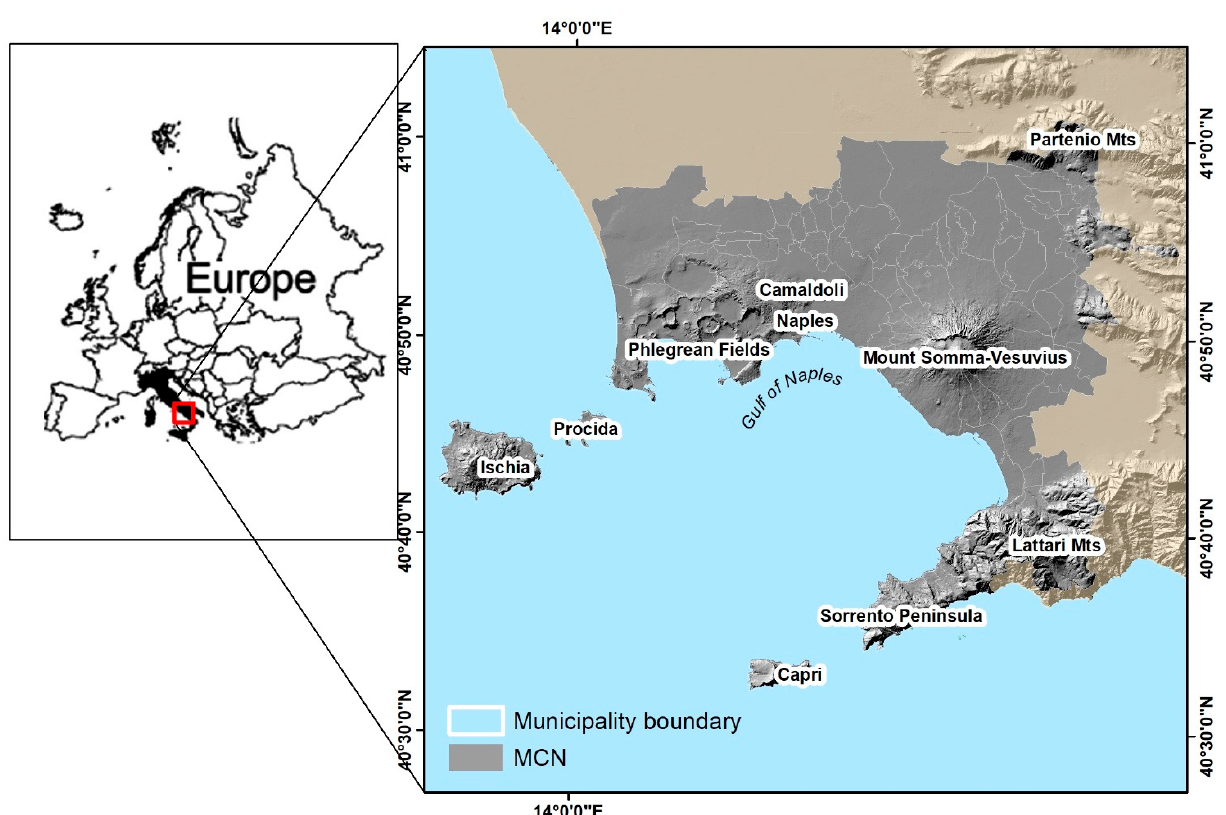
Figure 1. Study-area map: the Metropolitan City of Naples (MCN), located in Southern Italy.